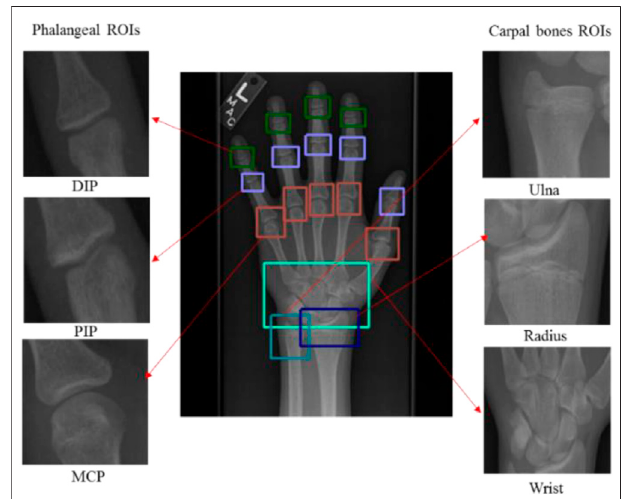
FIGURE 2 | Locations of six ROIs in